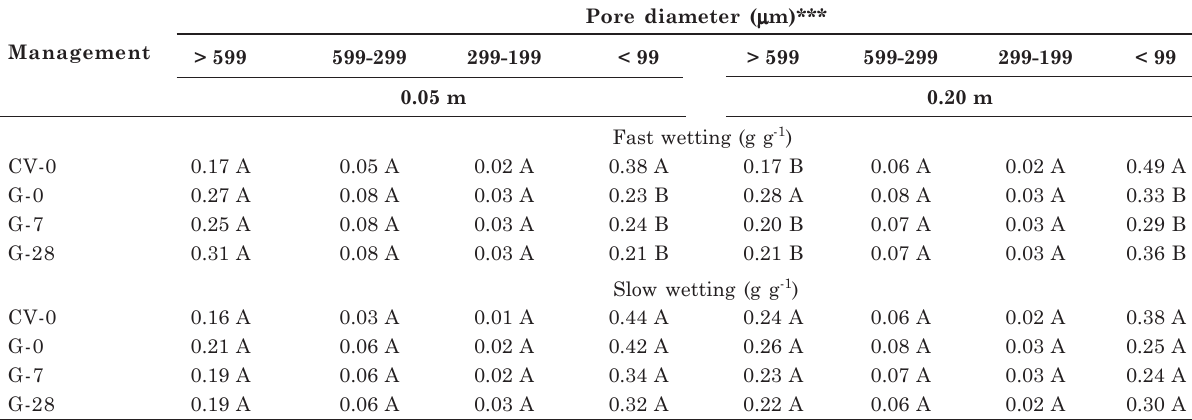
Table 5. Pore-size distribution obtained by the fast/slow wetting methods at a depth of 0.05 m and of 0.20 m under different management systems